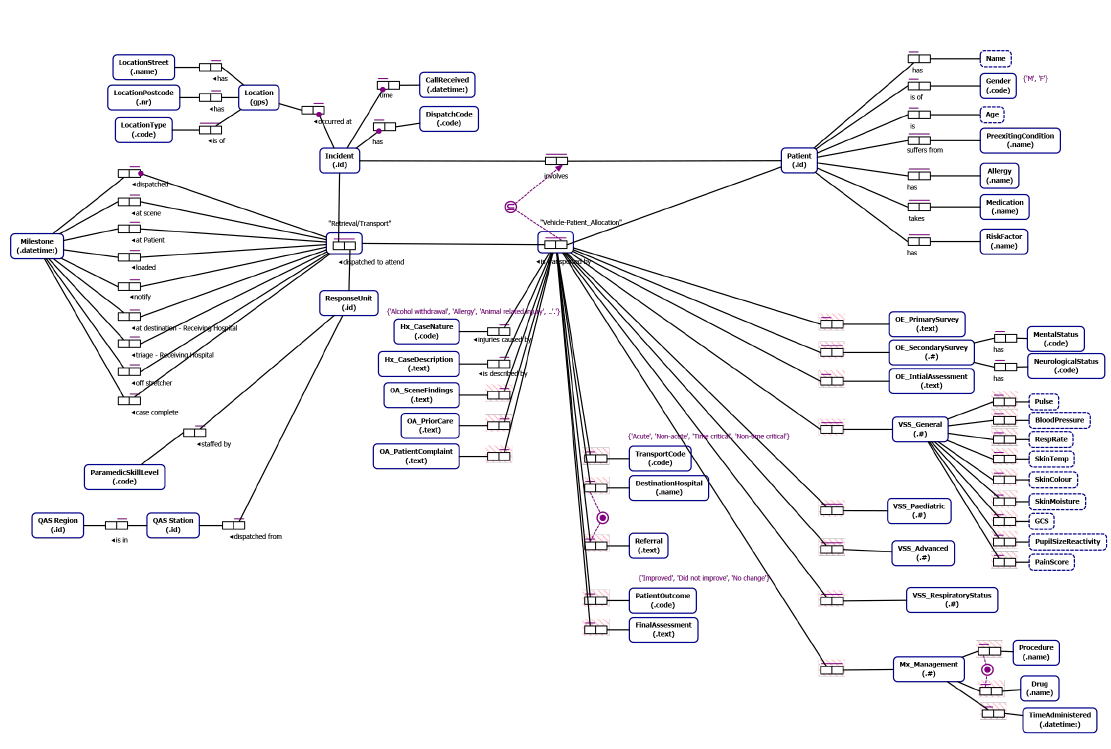
Figure 6. ORM model of QAS